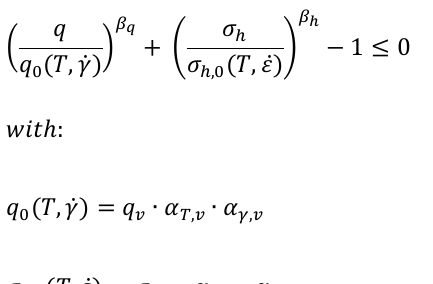
The GTM is now analytically rearranged from equation (14) to equation (15). The governing equation can be seen as the sum of two terms: the deviatoric term (first term) and the hydrostatic term (second term). In the derivation of equation (15), the functions a and b are converted in the function q between these functions are given by equation (18).